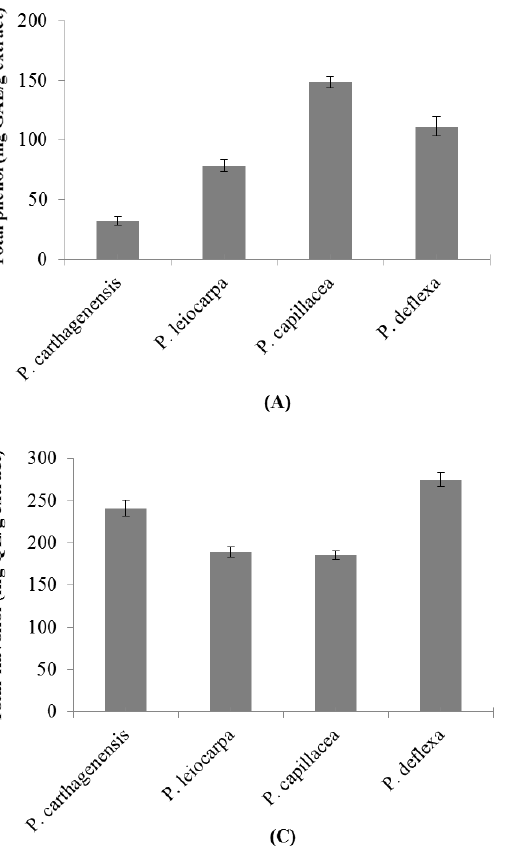
tannins ( D ) in P. carthagenis , P. leiocarpa , P. capillacea and P. deflexa extracts. The